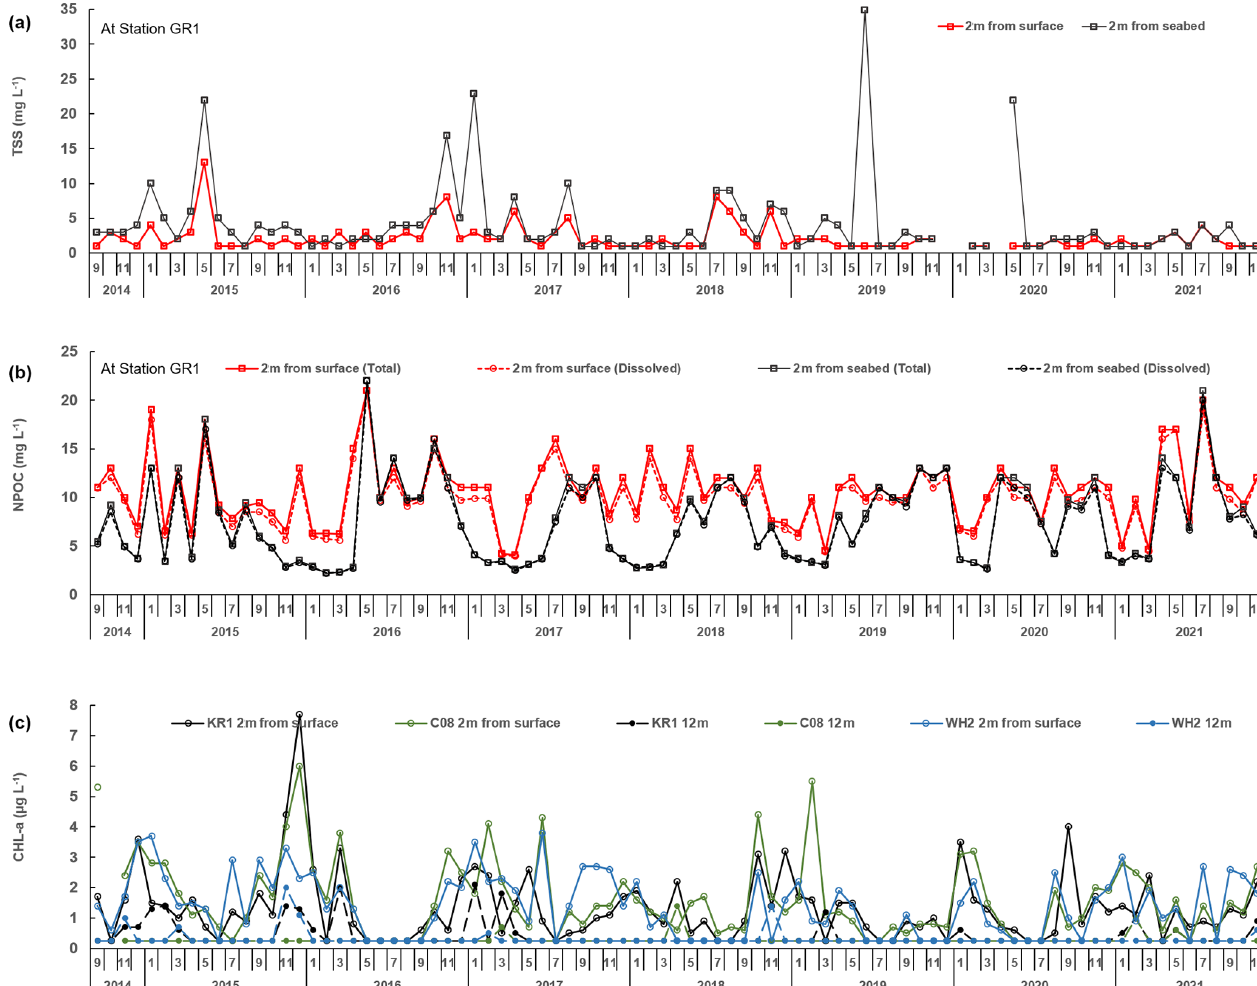
Figure A1. (a) Total suspended solids concentrations observed at station GR1. Samples collected 2m from surface (red) and 2m from seabed (black). (b) Total organic carbon (solid lines) and dissolved organic carbon (dashed lines) concentrations observed at station GR1. Samples collected 2m from surface (red) and 2m from seabed (black). (c) Chlorophyll a collected from stations KR1 (black), C08 (green), and WH2 (blue). Samples collected 2m from surface (solid lines, open symbols) and 12m from surface (dashed lines, closed symbols). All data displayed reflect dates from September 2014 to November 2021 and are used here as an example of Macquarie Harbour water column